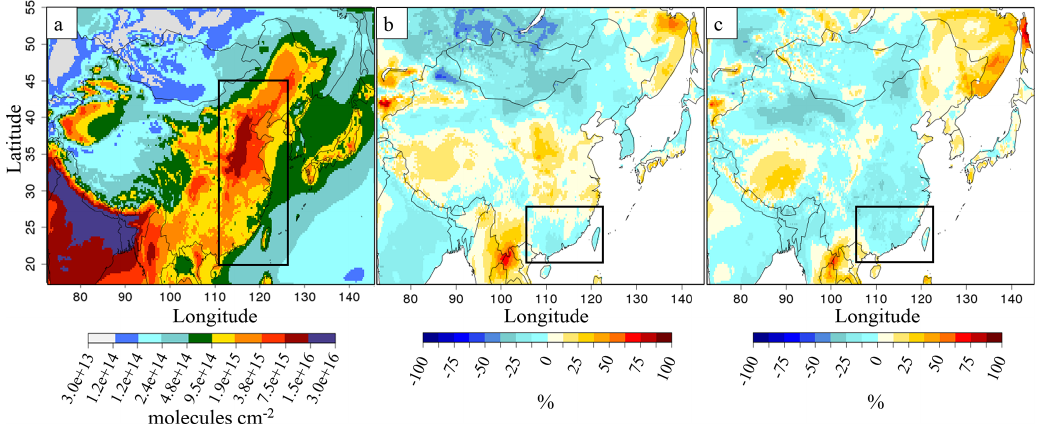
Figure 4. (a) Ammonia columns (moleculescm − 2 ) for the 2011A simulation; (b) relative differences (%) of ammonia columns between 2013A and 2011A; (c) relative differences between 2015A and 2011A. Note that as values over the sea mostly represent only small variations, we do not show them here and in the following figures.